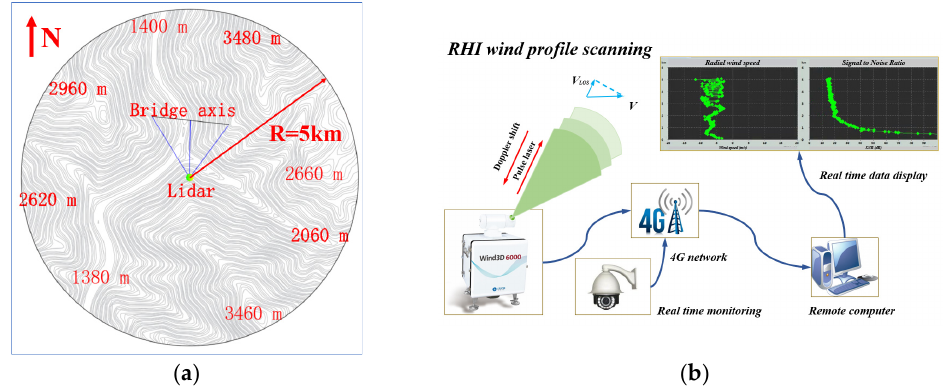
Figure 5. Diagram of Wind3D 6000 lidar wind measuring system. ( a ) Contour line at bridge site, ( b ) Wind3D 6000 Lidar system.